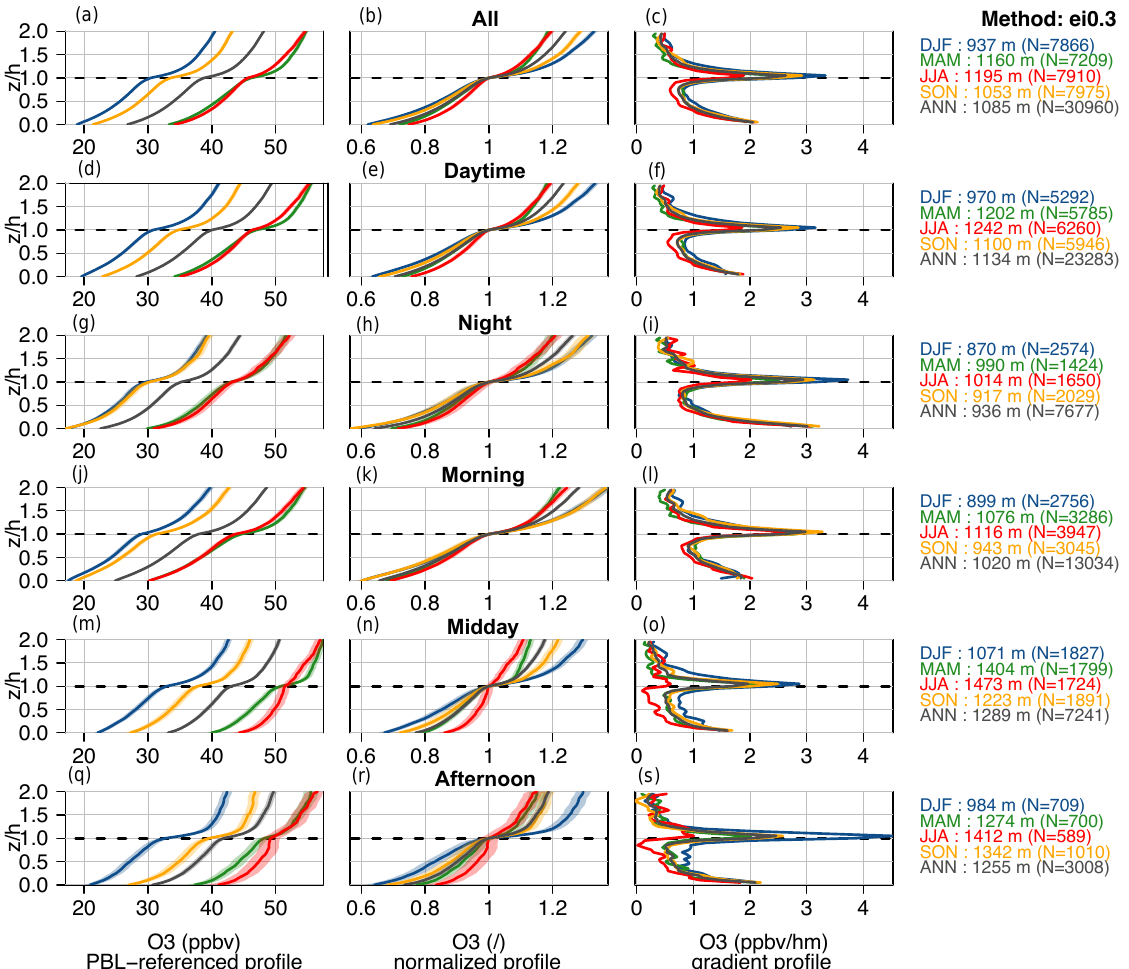
Figure 12. Same as Fig. 7 for O 3 mixing ratios (in